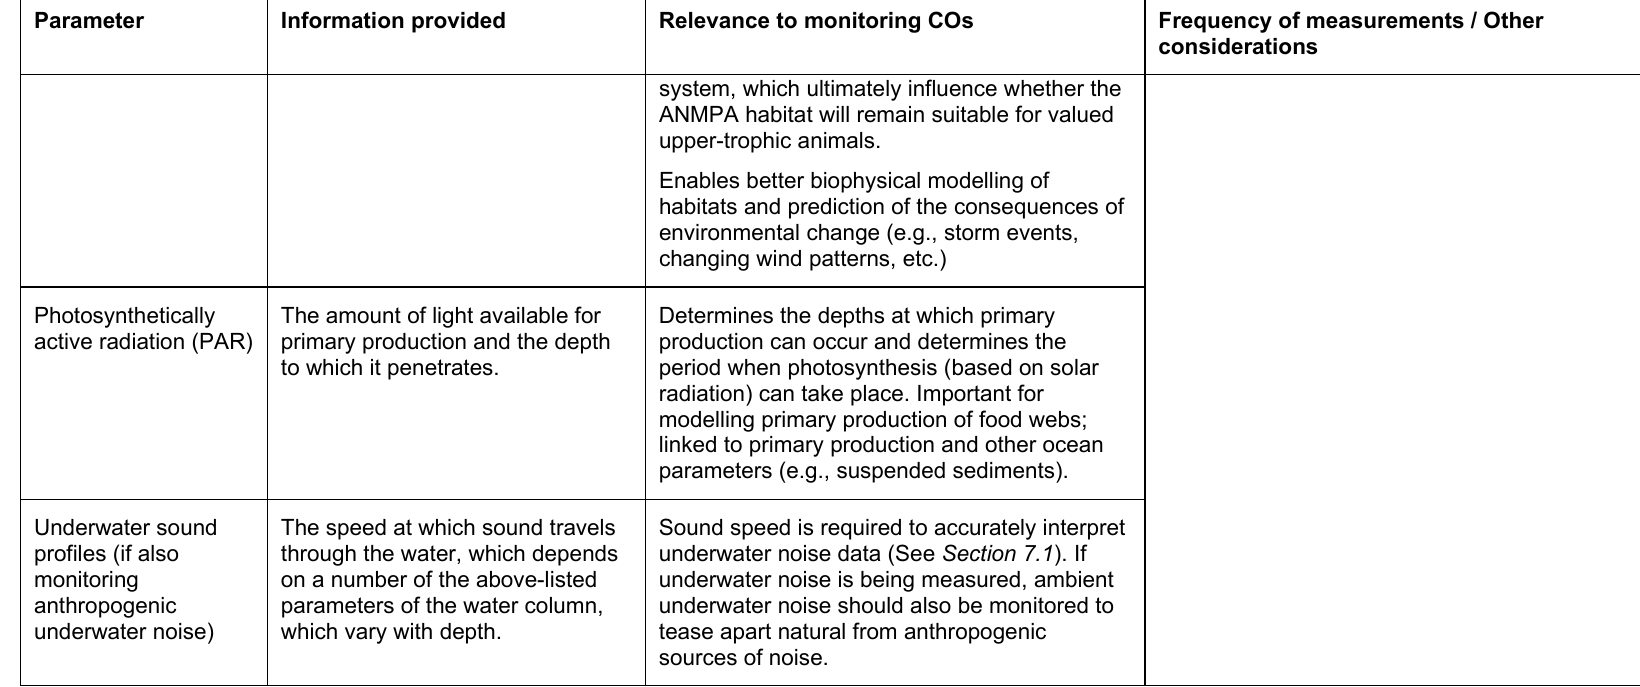
Table C2. Key measurement parameters for monitoring ice structures, snow and ice thickness, and ice break-up/freeze-up timing (Section 5.2).